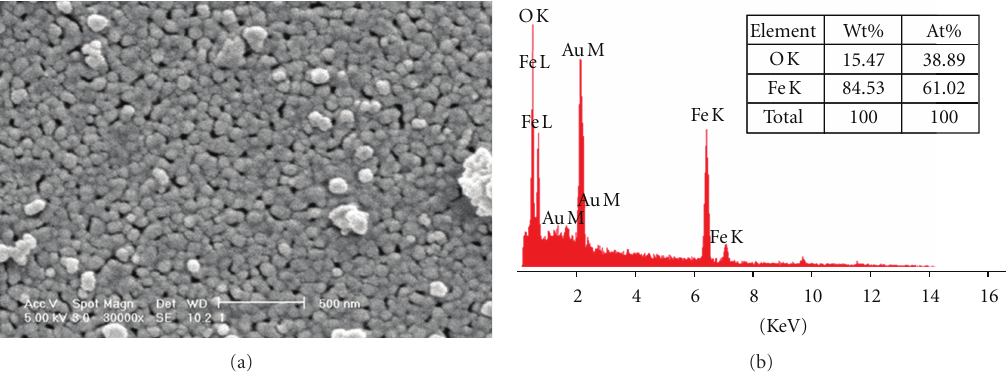
Figure 1: SEM image and EDX spectrum for γ -Fe 2 O 3 nanoparticles.